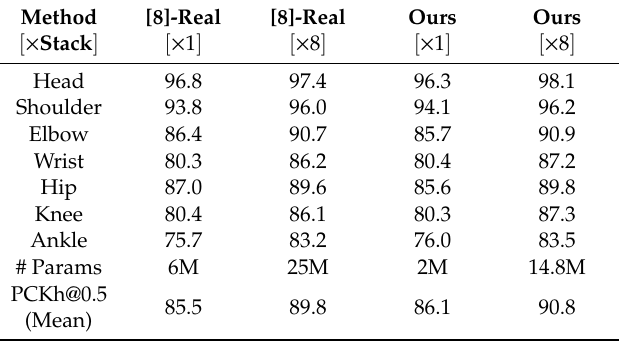
Table5. Comparisonwithstate-of-the-artlightweighthourglassmethodswiththeMPIIvalidationdataset.